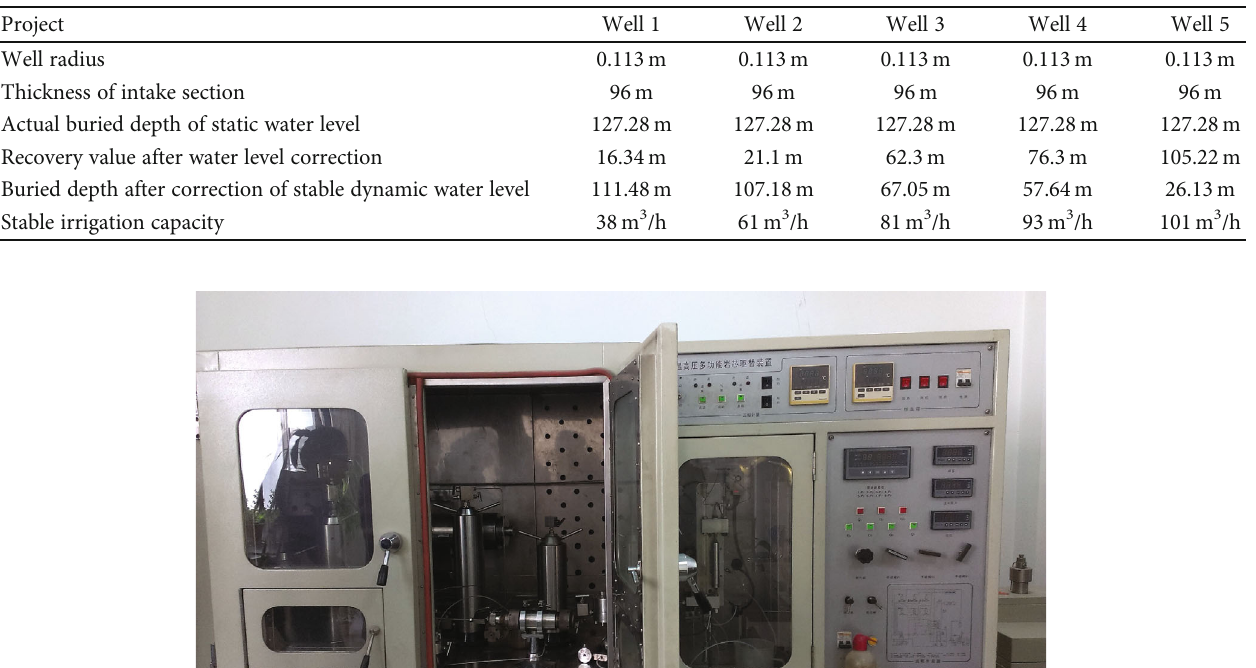
Table 6: Reinjection data.